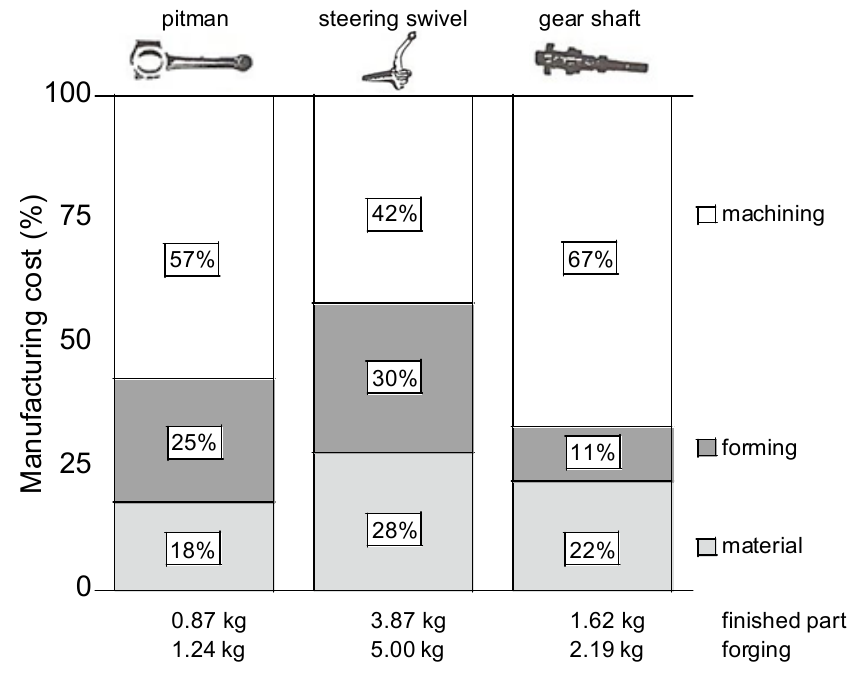
Figure 1. More than 40% of the total manufacturing cost in component manufacturing comes from different machining operations